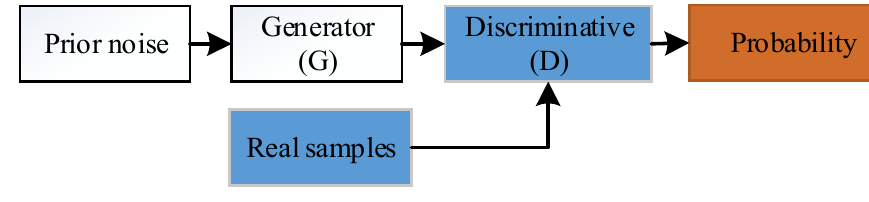
Figure 1. The GAN